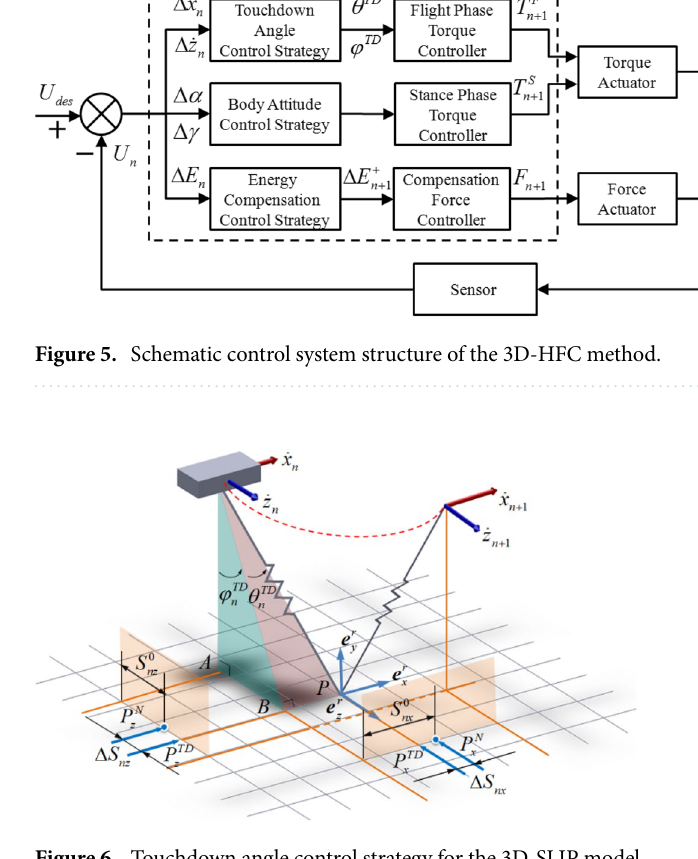
Figure 6. Touchdown angle control strategy for the 3D-SLIP